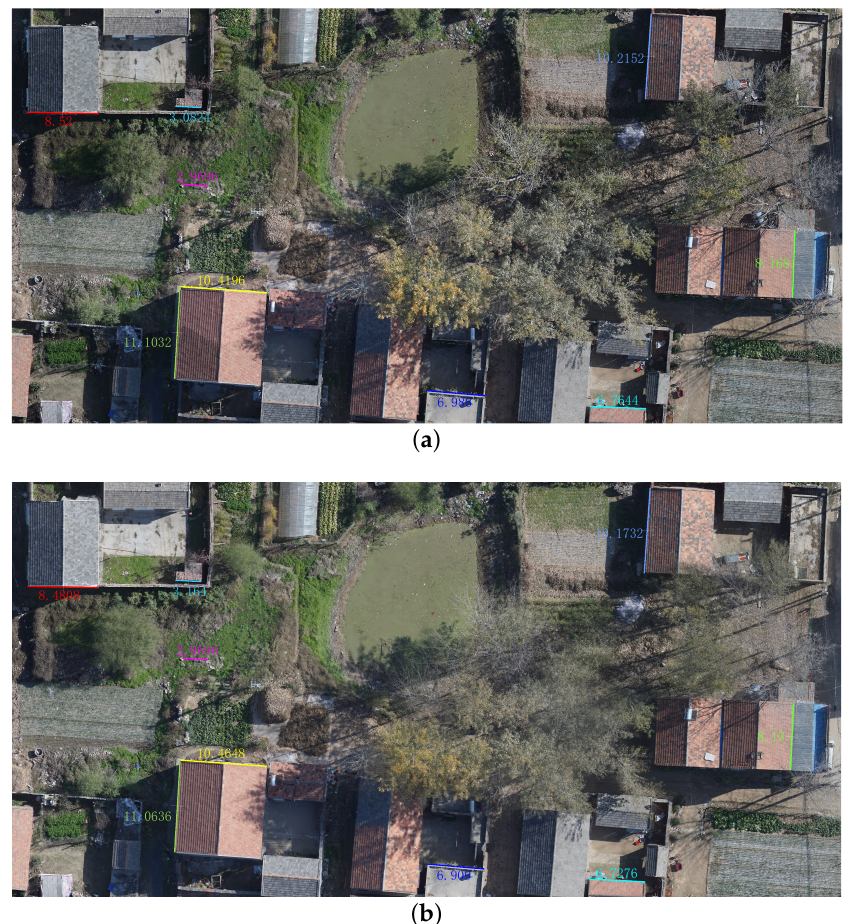
Figure 19. Comparison of length measurement between TDM and Pix4D. The two images are the digital orthophoto generated by TDM and Pix4D. The number next to each colored line indicates the measured distance. ( a ) Length measurement of TDM. ( b ) Length measurement of